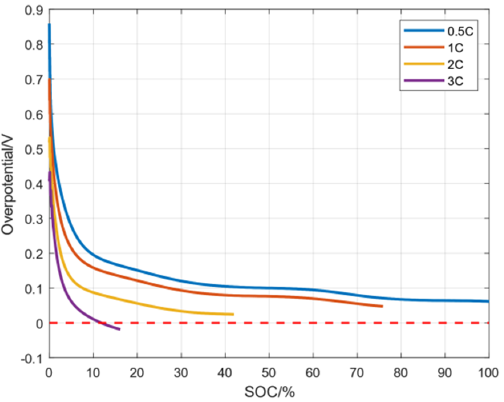
Figure 5. The overpotential of electrode particles with m = 1under different charging rates.